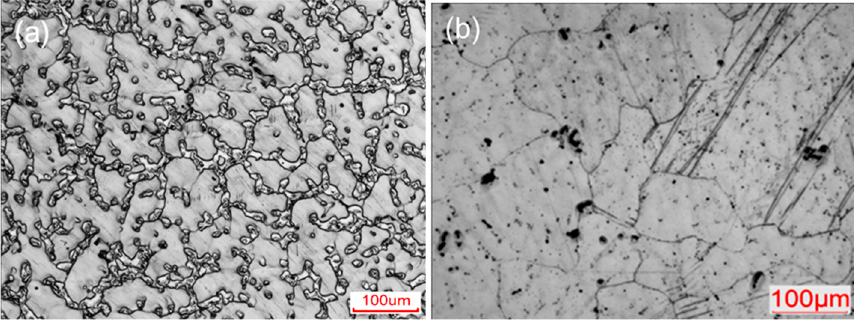
Figure 2. Optical micrographs of ( a ) as ‐ cast and ( b ) as ‐ homogenized AZ91 alloys.